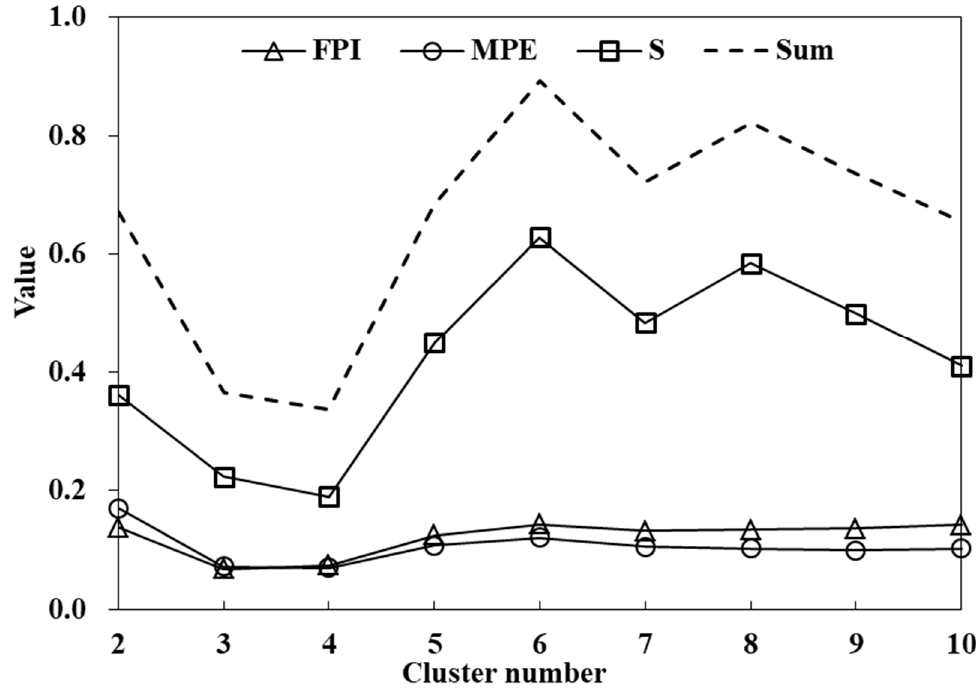
Figure 5. The metrics of spectra clustering derived from Landsat 8 OLI data.